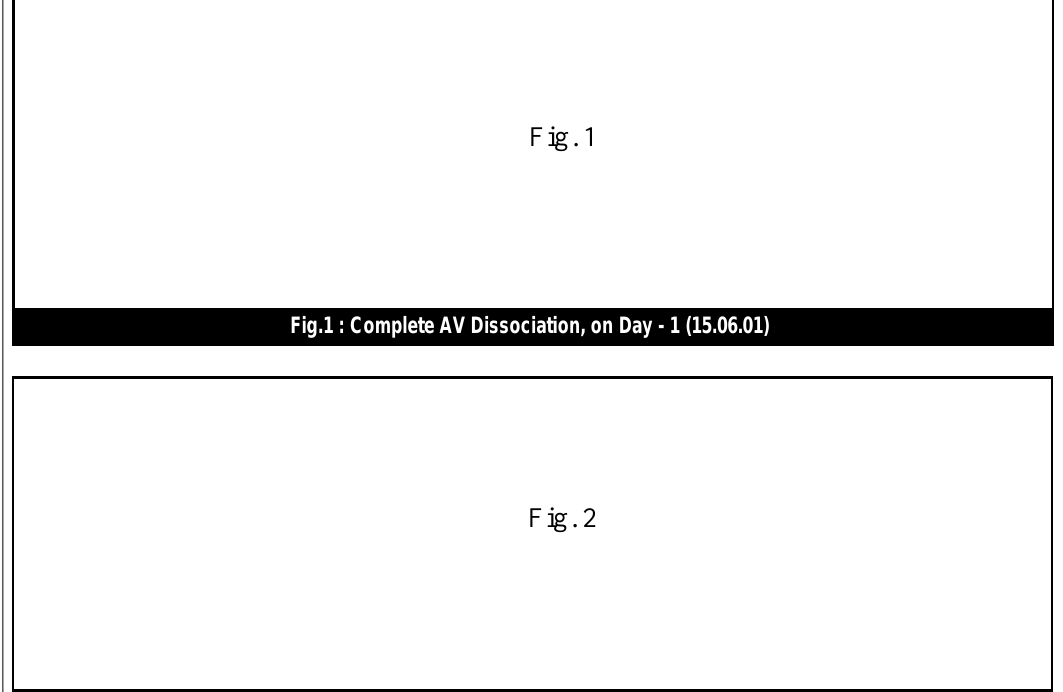
Fig.2 : Sinus Bradycardia with Junctional Escape, on Day - 1 (15.06.01)